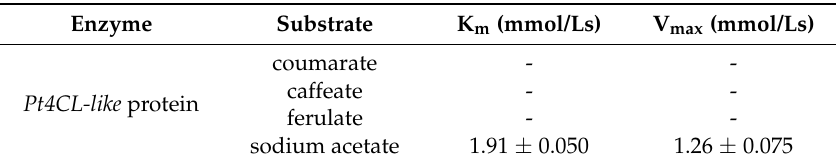
Table 3. Different substrates’ K m and V max .